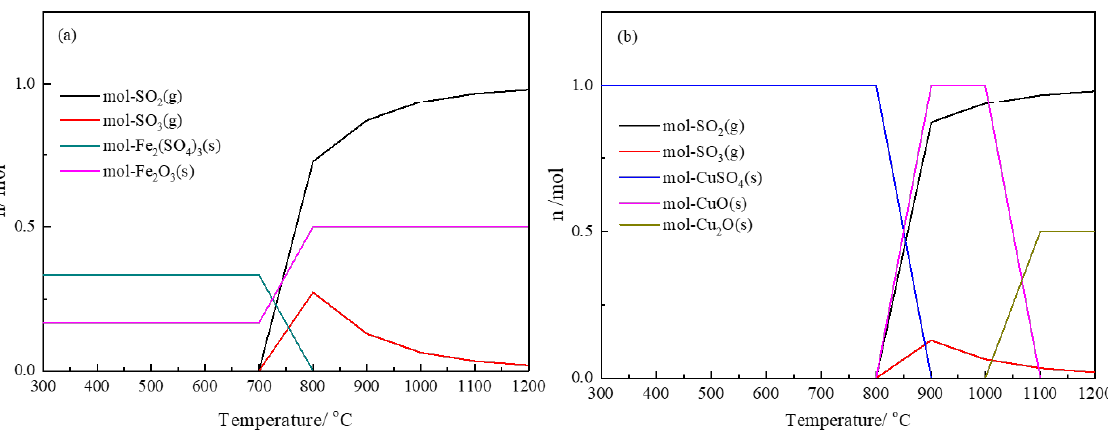
Figure 3. Desulfurization of matte in oxidation roasting ( a ) Oxidation of FeS; ( b ) oxidation of